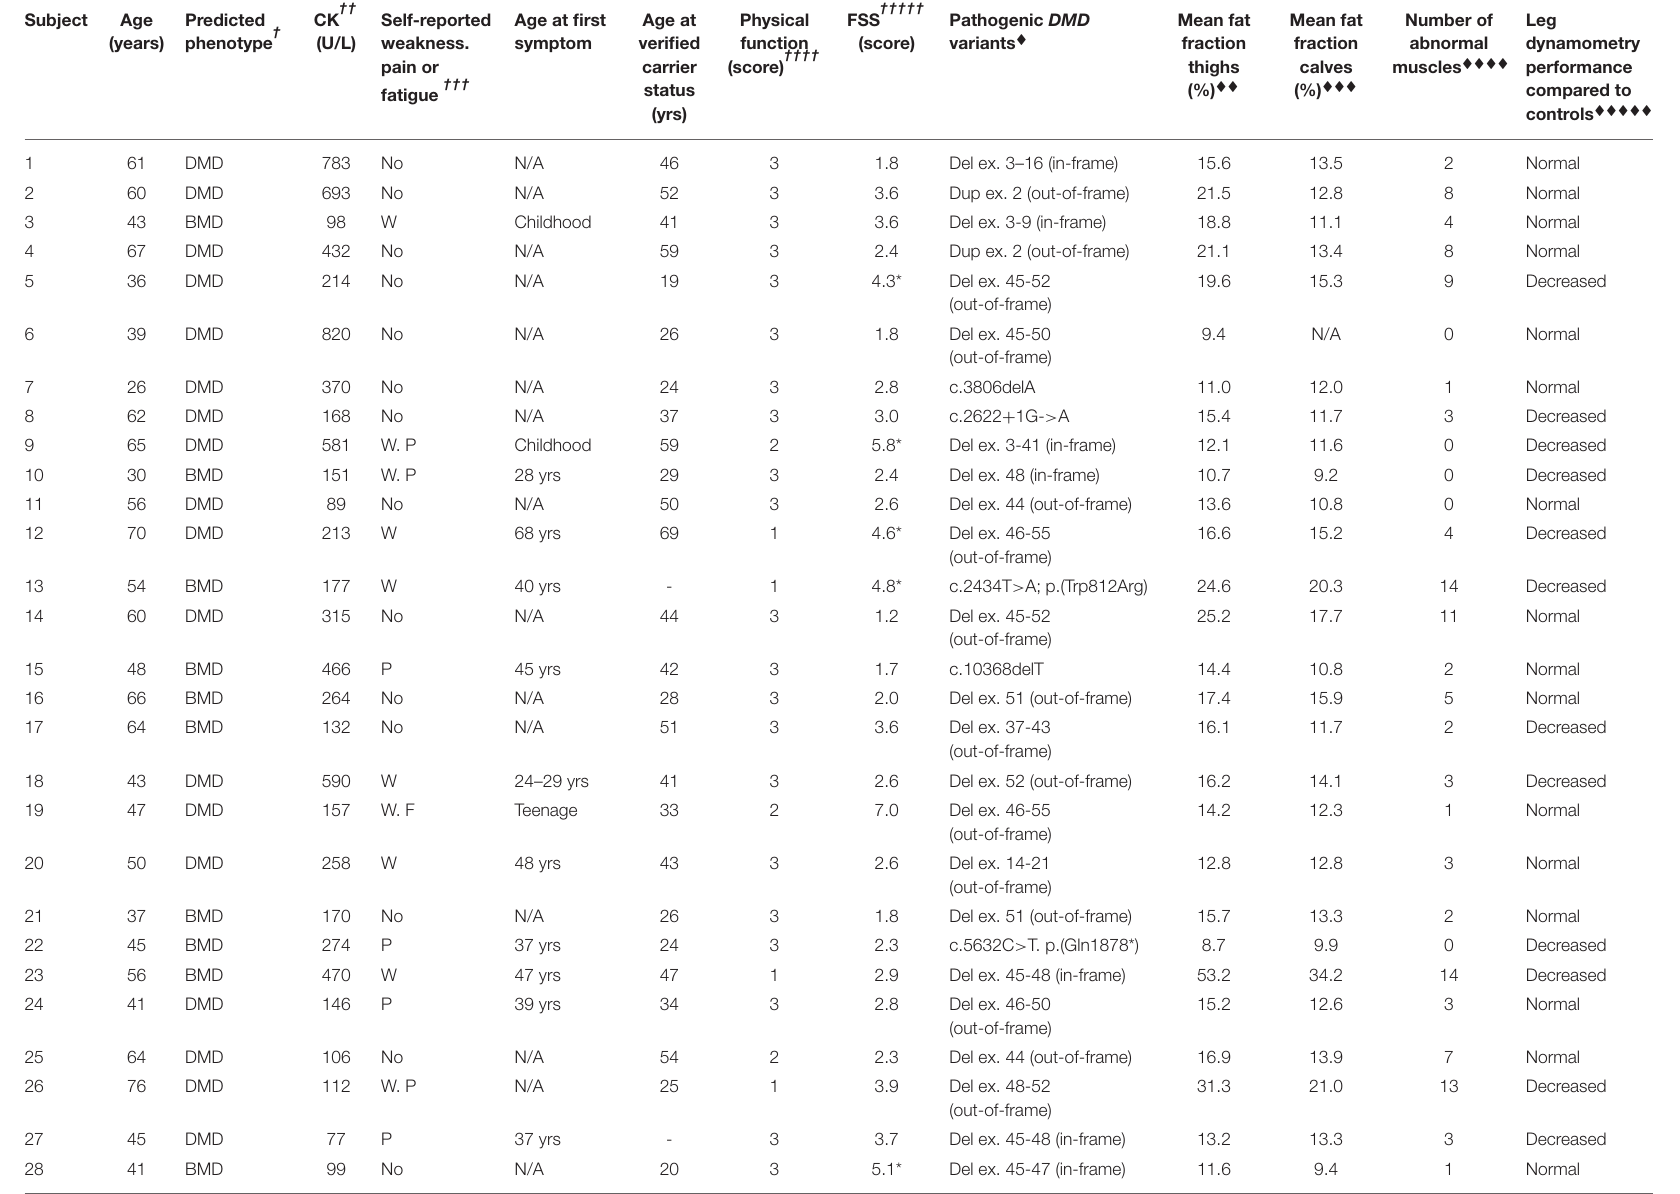
TABLE 1 | Demographics and characteristics of the 53 women with pathogenic variants in the dystrophin